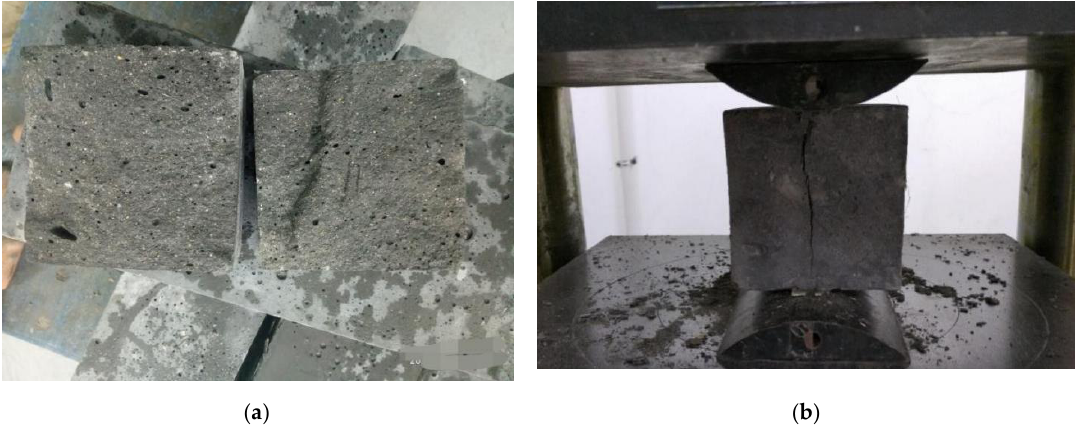
Figure 6. Splitting tensile failure morphology: ( a ) RPC, ( b ) carbon-fiber RPC.